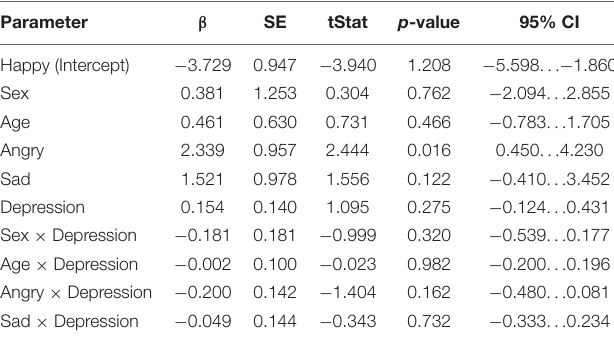
TABLE 3 | Results of the linear mixed-effects regression model (DF = 162) in the intermediate time window (240–280 ms).